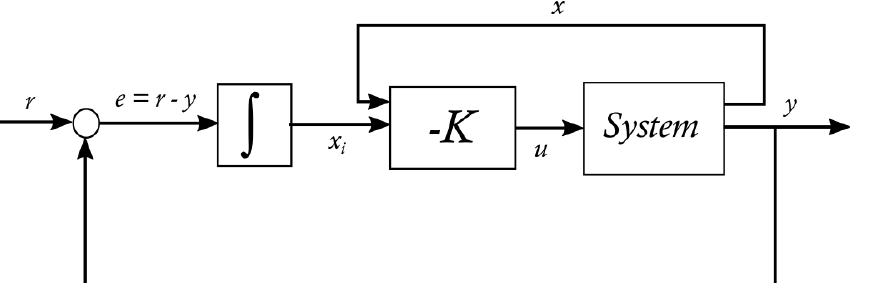
Figure 3. Linear quadratic integral (LQI) control system block